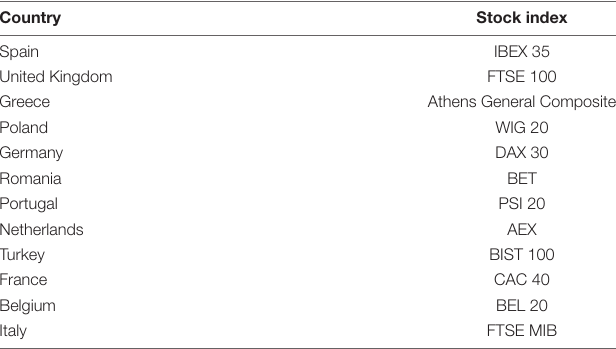
TABLE 1 | Countries and stock indices taken as reference points. Country